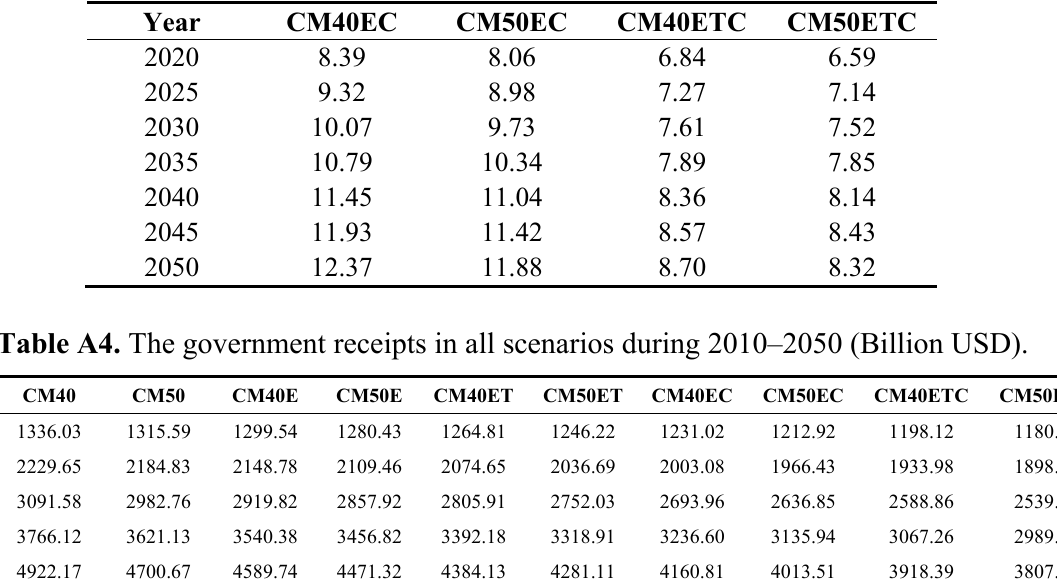
Table A3. The estimated revenues of carbon tax during 2020–2050 (Billion USD).